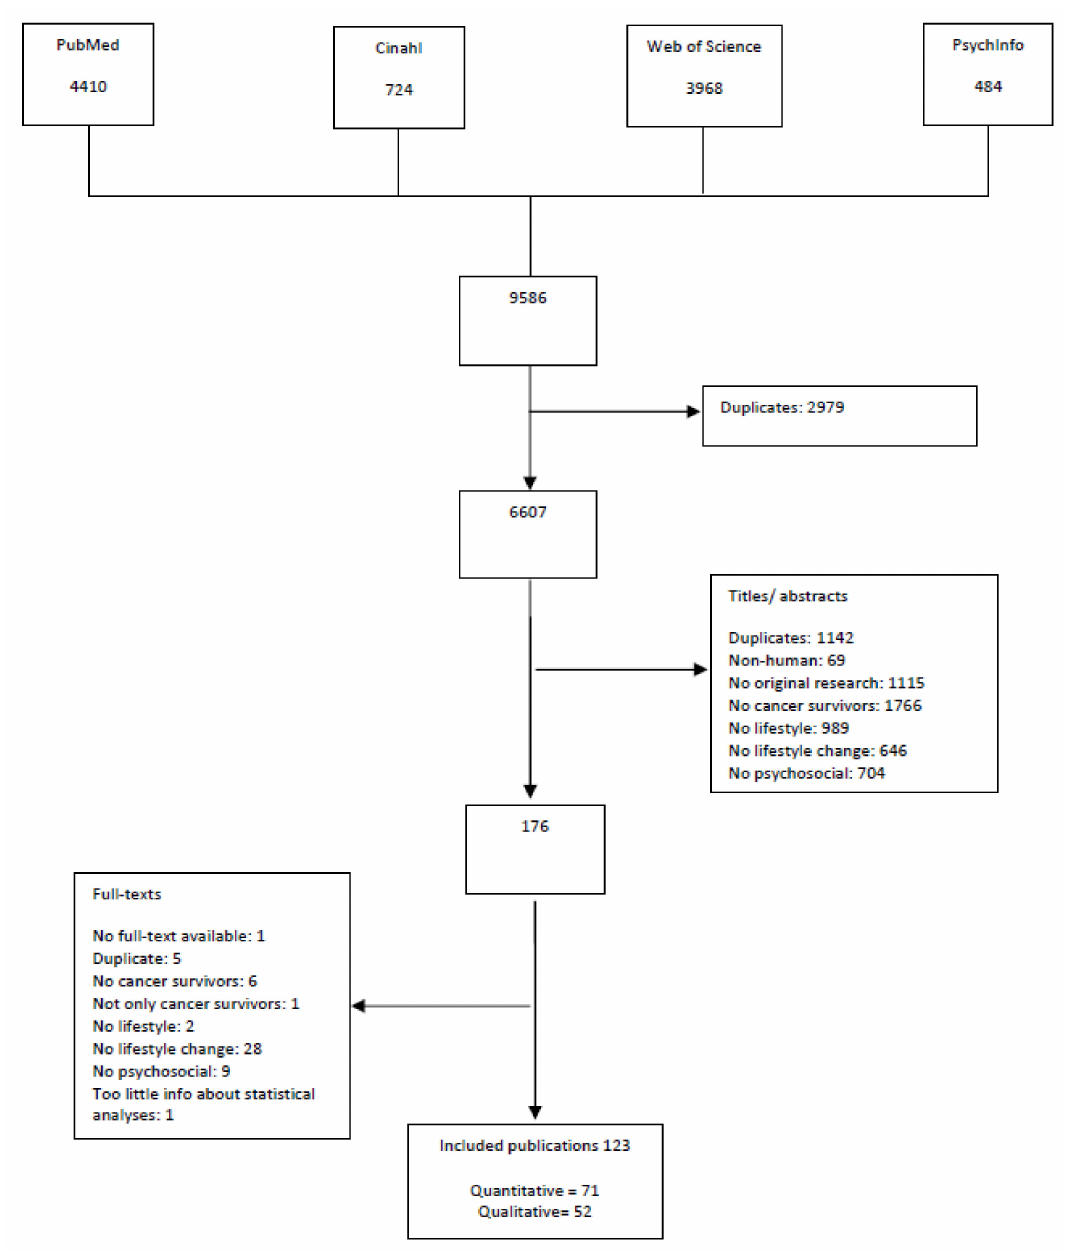
Figure 1. Flow-chart of inclusion and exclusion of publications derived from the database